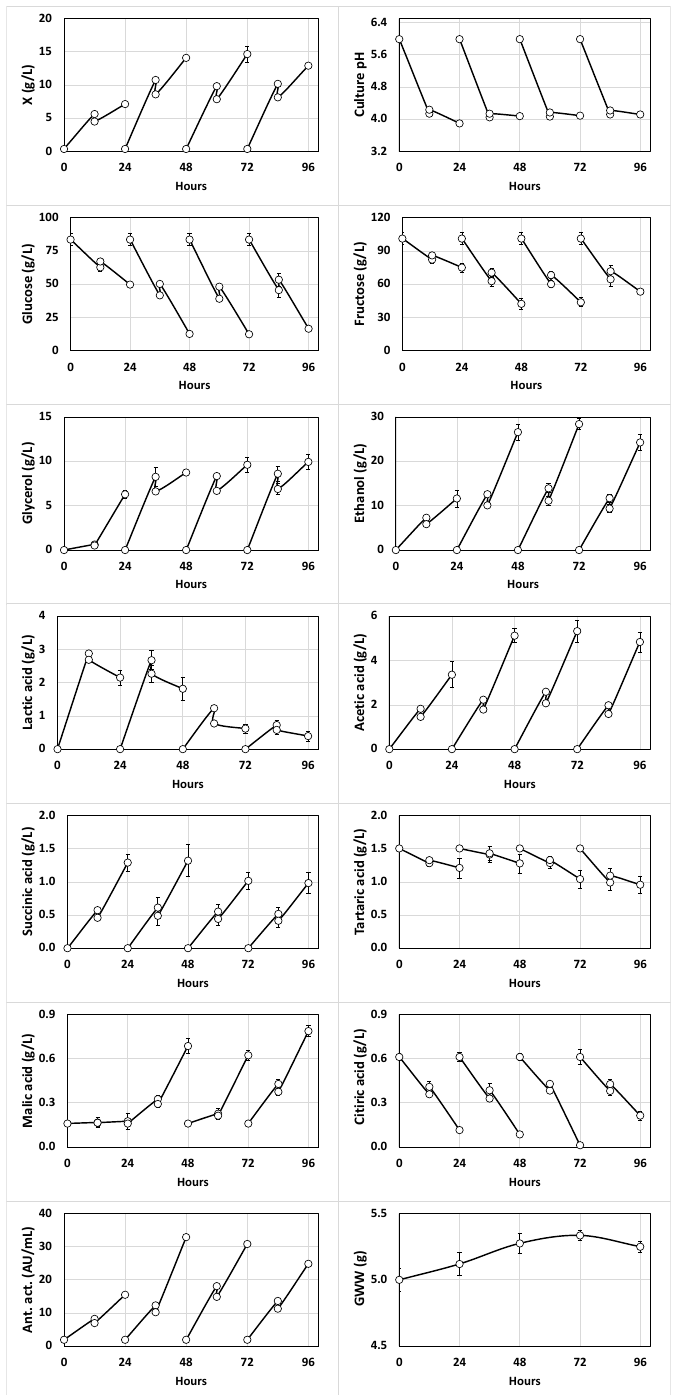
Figure 2. Kinetics of growth (X), culture pH, glucose, fructose, alcohols (glycerol and ethanol) and organic acids (lactic, succinic, tartaric, malic and citric); antibacterial activity (Ant. act.); and grain wet weight (GWW) in the 24-h fed-batch subcultures of red table grape juice at initial pH 5.99 fermented with kefir grains. The different subcultures were fed with fresh juice at 12, 36, 60 and 84 h,